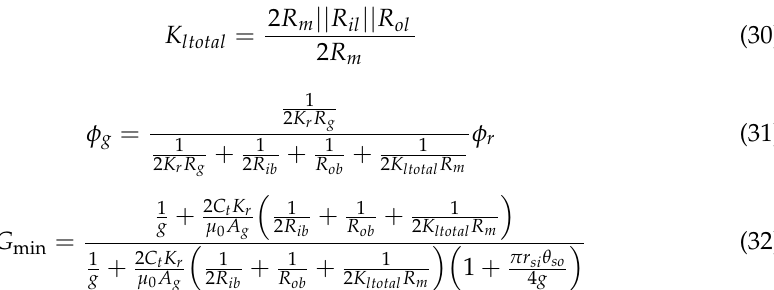
Figure 11. Comparison of the cogging torque derived from the HMEC and the FEM.